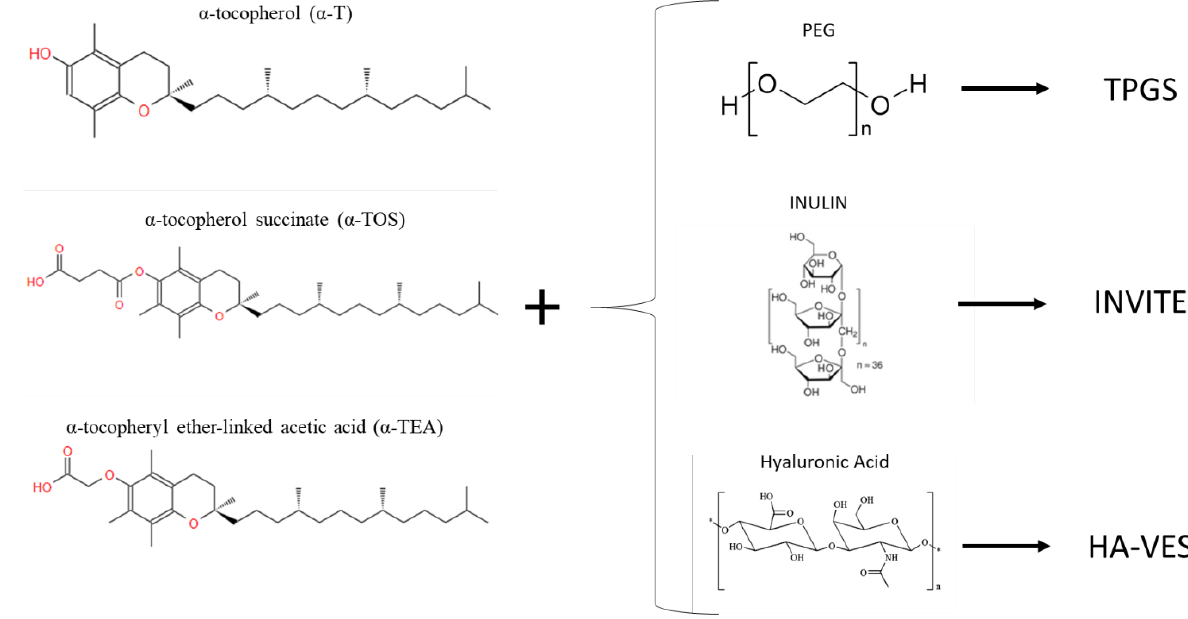
Figure 5. Chemical structure of different forms of vitamin E used for drug delivery system.